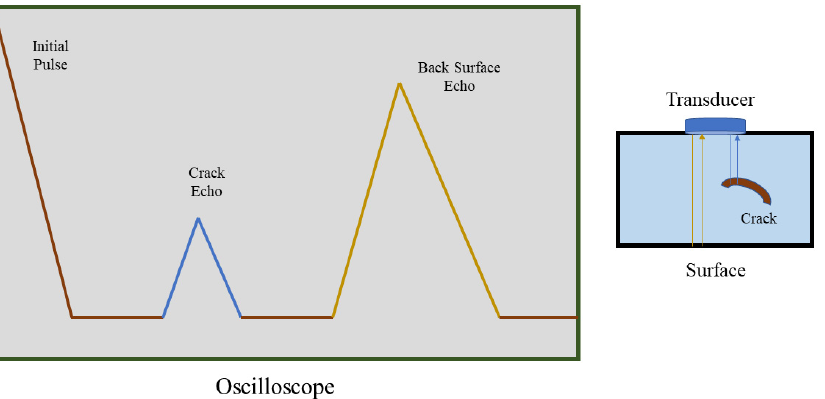
Figure 1. An illustration of the ultrasound detection technique using an ultrasound sensor and a surface (solid) with an internal crack. Information about the approximate size and position of the defect can be viewed using an oscilloscope.